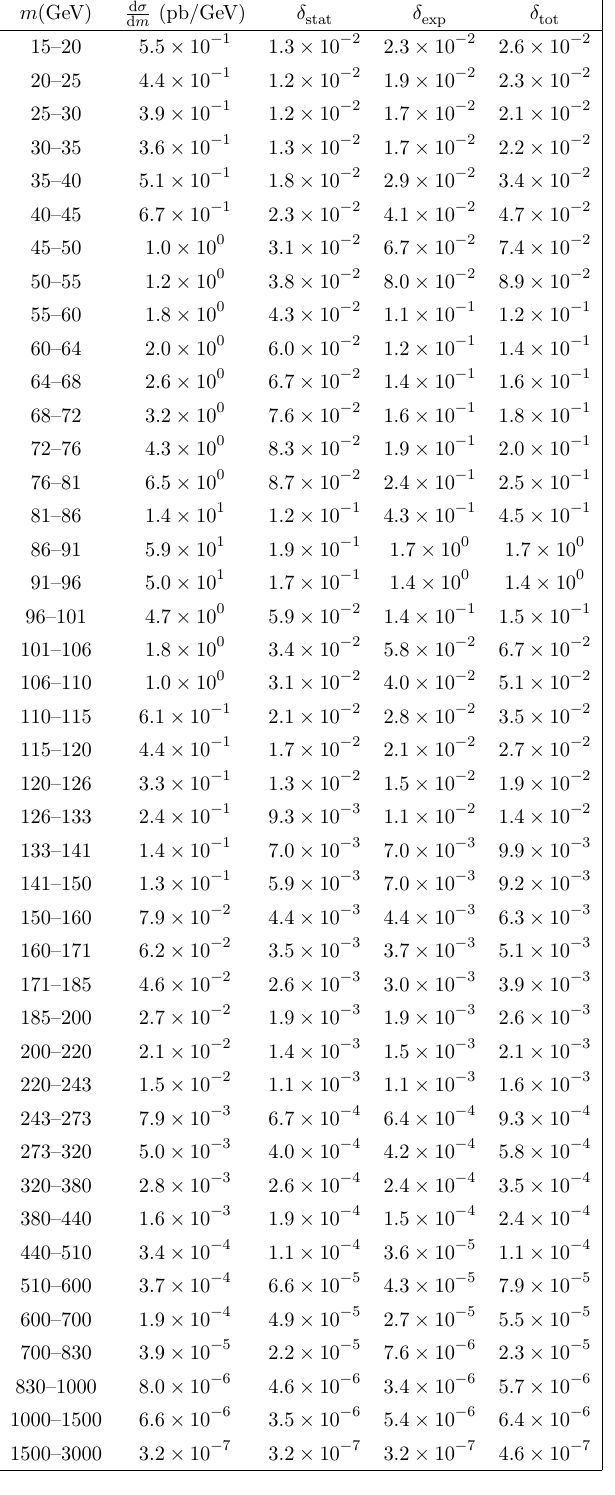
Table 6 . Summary of the measured values of (cid:12)ducial d (cid:27)= d m (pb/GeV) (with no FSR correction applied) in the dielectron channel with the statistical ( (cid:14) ) and experimental ( (cid:14) ) uncertainties stat exp shown separately. Here, (cid:14) is the quadratic sum of the two components. tot